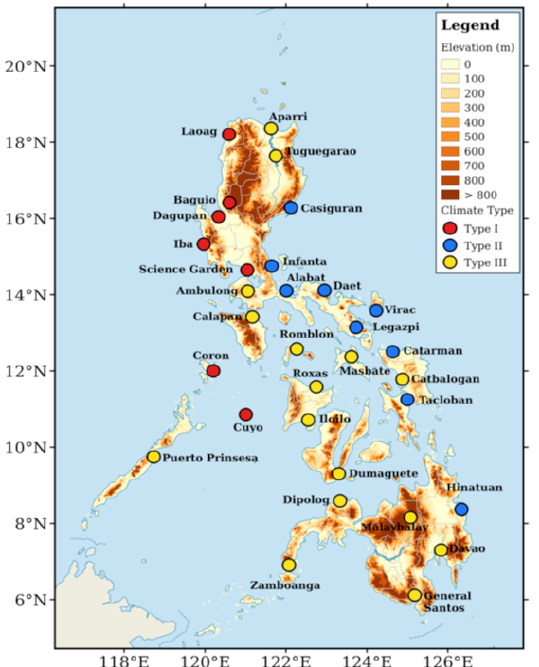
Figure 1. The location of the 32 stations from the Philippine Atmospheric, Geophysical and Astronomical Serviced Station (PAGASA) and the topography of the Philippines (shading; m). The colors of the circles indicate the climate types based on Villafuerte et al. [36].